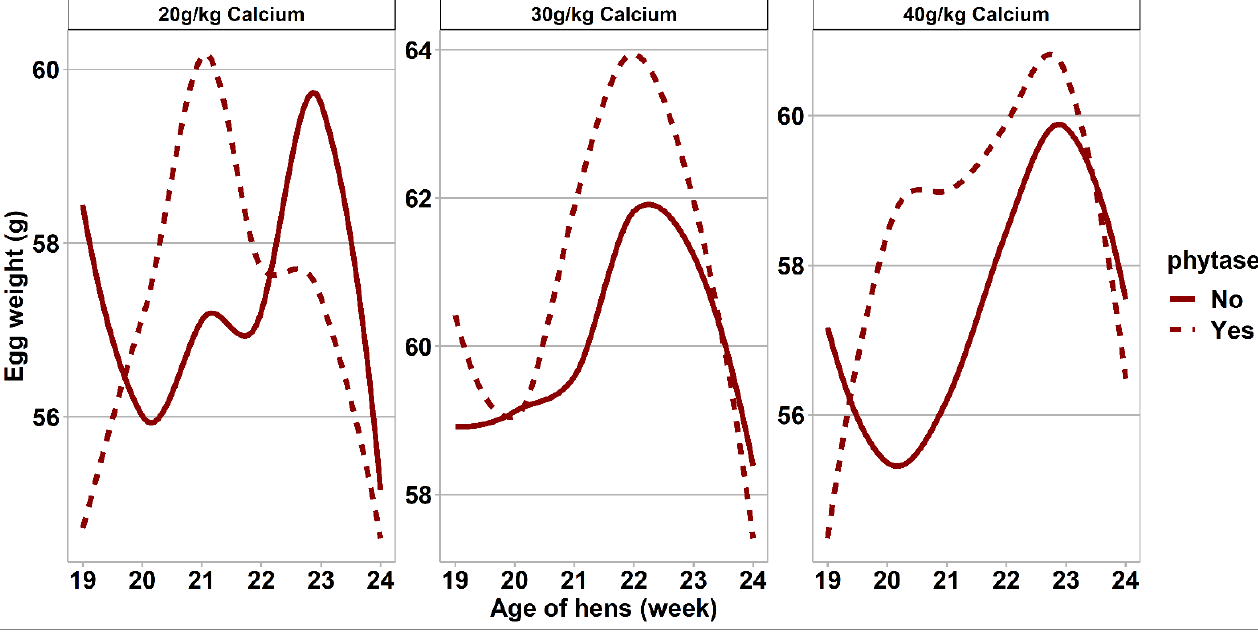
Figure 3. Trendlines visualize the impact and interaction of the calcium level and phytase inclusion of the diet on egg weight during the 6-week experimental period (n = 48).